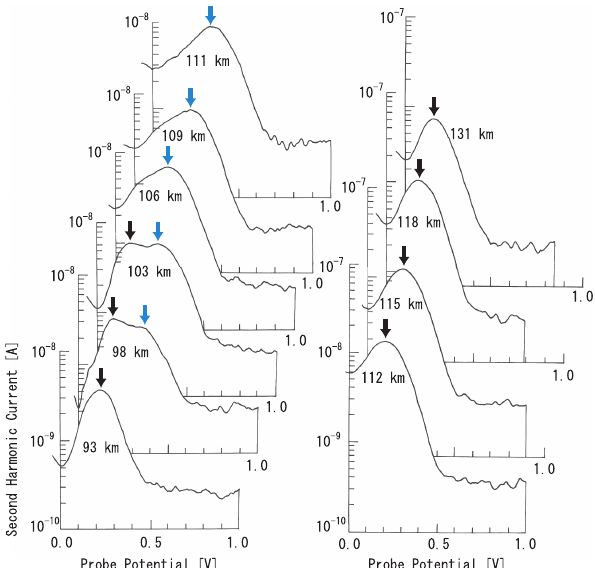
Fig. 1. Second harmonic components at the heights of 93–131km. Horizontal axis is the probe potential (energy of electrons) and ver- tical axis is the second harmonic component in amperes. Please note the second peak marked by a blue arrow at the heights of 98km, 103km, 106km, 109km and 111km. The symptom of the peak starts to appear from the height of 98km. The current below 3 × 10 − 10 A is noise of the